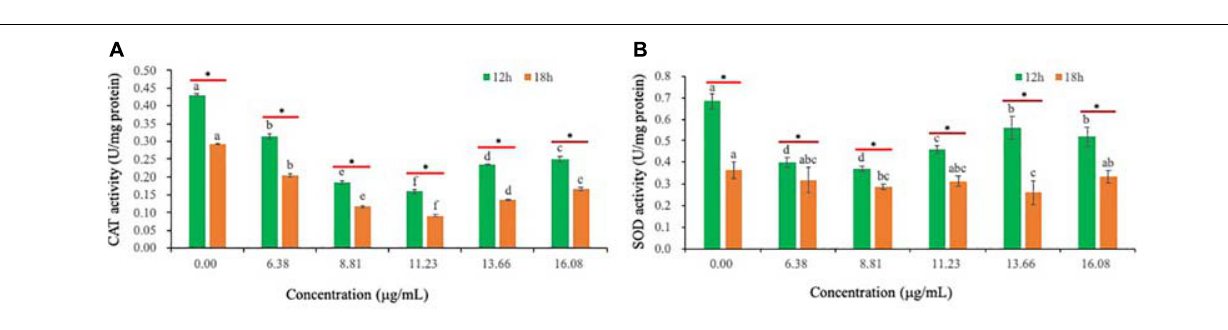
Frontiers in Microbiology |